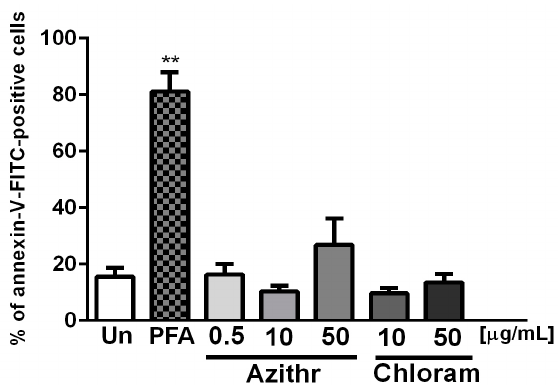
Figure 2. Effect of azithromycin and chloramphenicol on apoptosis assessed by annexin V-FITC and propodium iodide binding; paraformaldehyde (PFA) constituted positive control ( n = 6) (** p ≤ 0.01 vs . unstimulated cells (Un)).